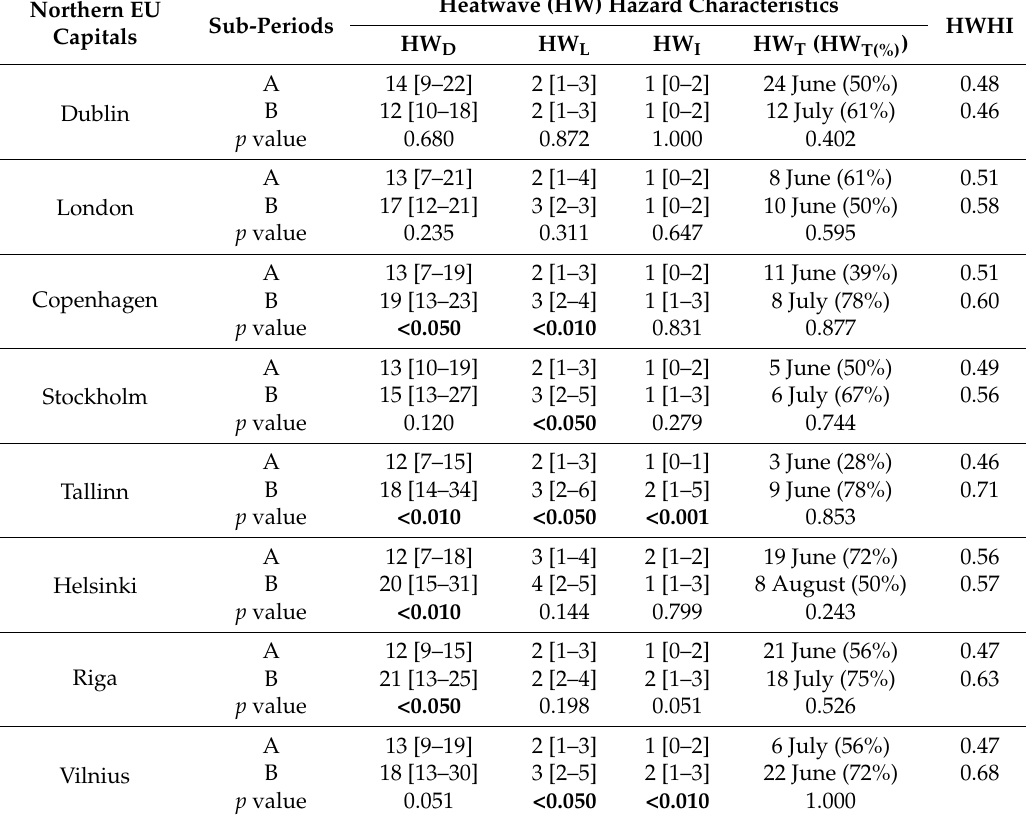
Table 5. The median of heatwave (HW) hazard characteristics (HW D : HW days; HW L : long HWs; HW I : high-intensity HWs; HW T : the timing of the first simultaneously long and high-intensity HW) and the value of the Heatwave Hazard Index (HWHI) referred to the 1980–1997 (A) and the 1998–2015 (B) 18-year sub-periods for northern EU capitals. The 75th and 25th percentiles of HW D , HW L and HW I (in square brackets) and the frequency of years with at least one simultaneously long and high-intensity HW (HW T(%) in round brackets) are shown. The significance level ( p value) of associations between the two 18-year sub-periods are shown (bold when